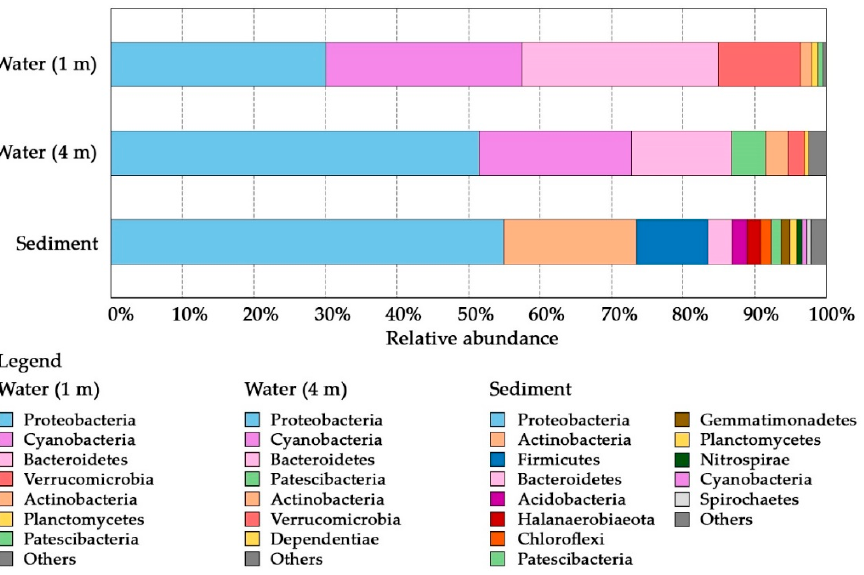
Figure 2. Relative abundance of major bacterial phyla from Lake Alboraj water and sediment. Only phyla with a relative abundance >0.5% of total bacterial population were included.